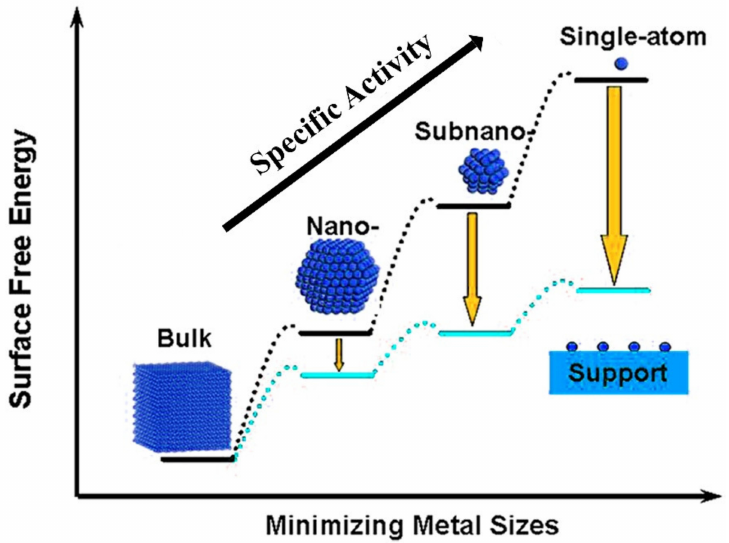
Figure 16. Scheme of metal particles reduced to an atomic scale and increase in free surface energy Adapted form